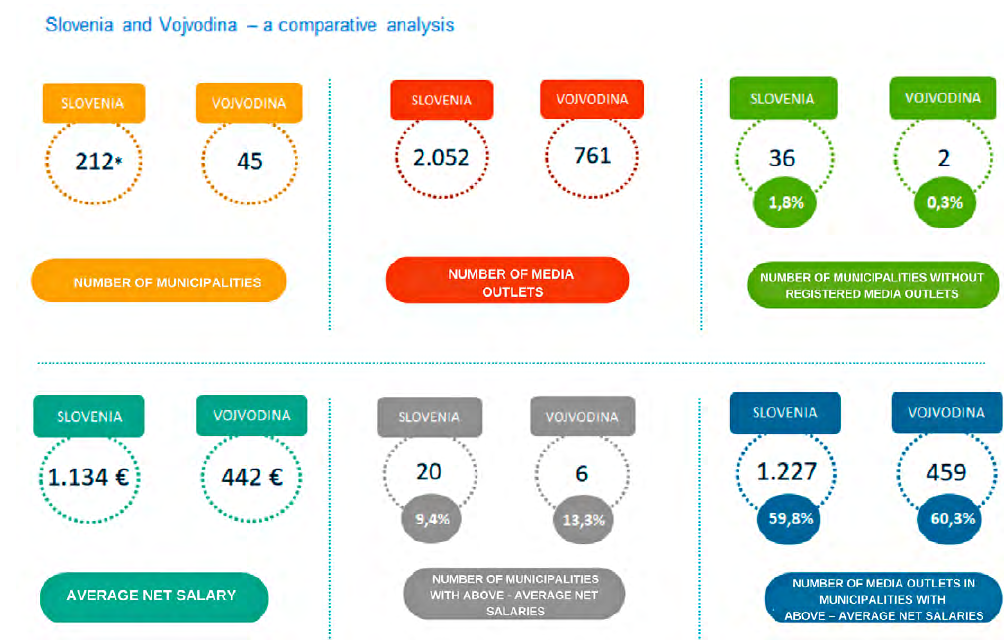
Figure 5. Comparative analysis of various quantitative